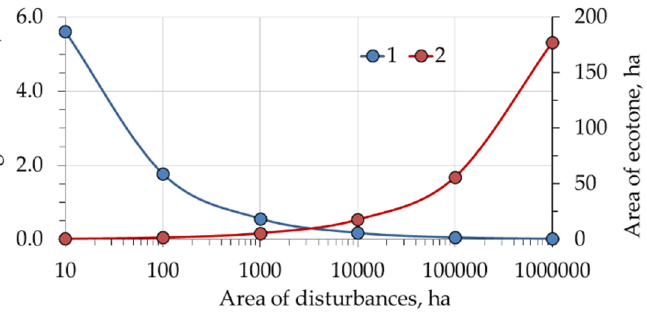
Figure 8. Areas and percentage of the emerging transitional zone (“ecotone”) versus the total area of the disturbed plots. In the calculations, we used the approximation of the circular shape of the disturbed plots. 1 is the percentage of ecotone; 2 is the area of ecotone.